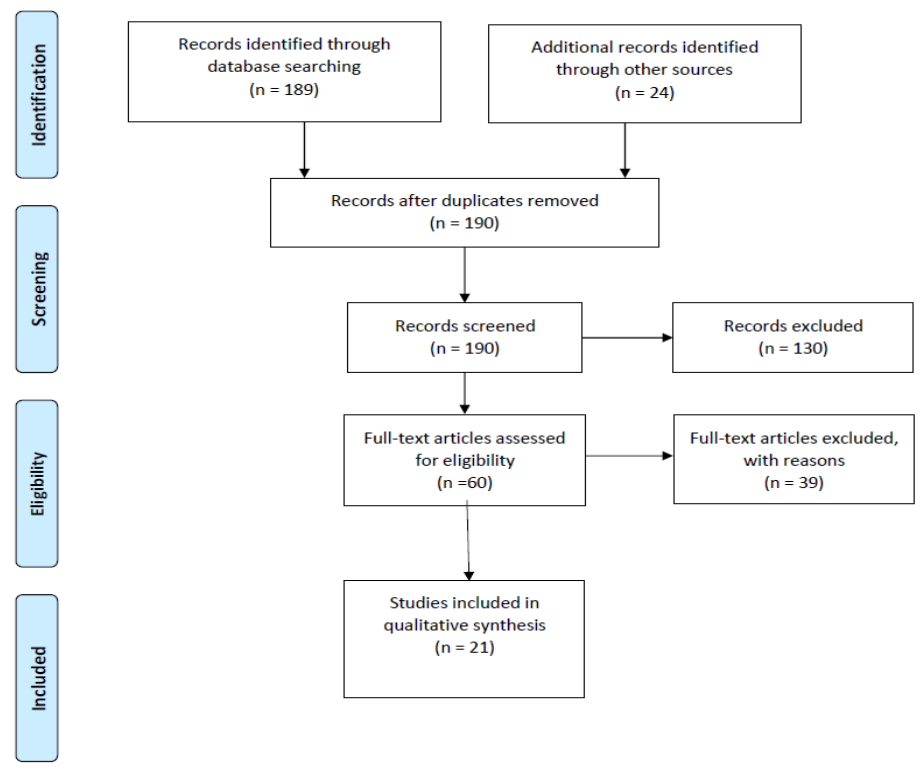
Figure 1. Collection of adequate studies on the basic pre-defined criteria (PRISMA flow chart). Table 3. Research studies where IFT 30–15 was used to verify validity, reliability and aerobic capacity